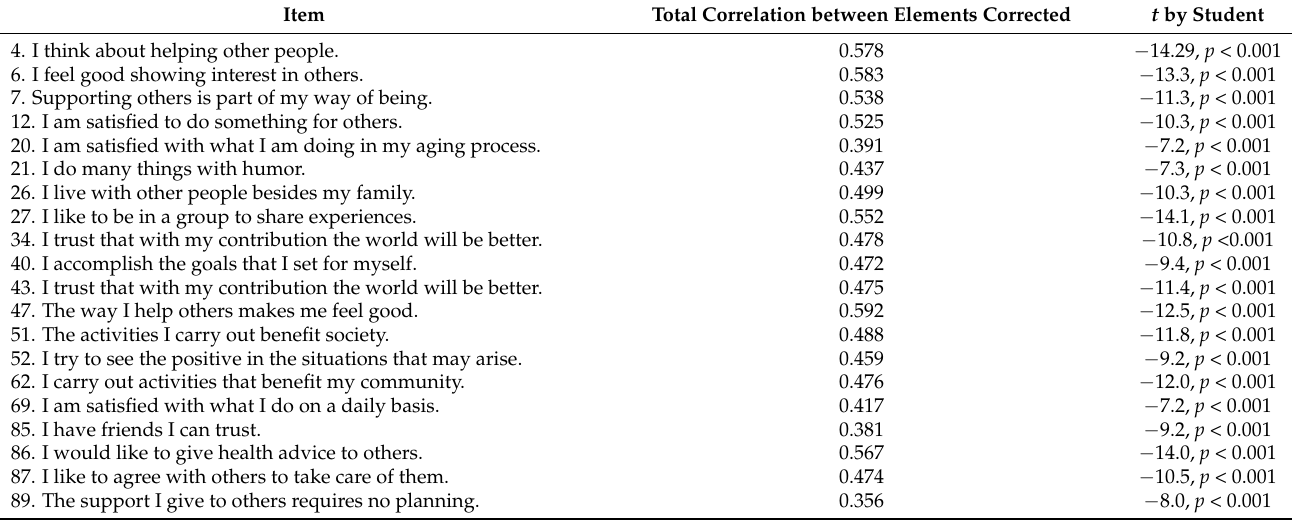
Table 4. Total correlation between the corrected items and Student’s t -test. ( n =